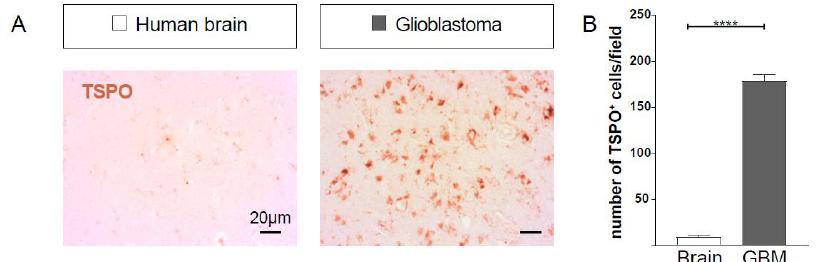
Figure 1. Mitochondrial translocator protein (TSPO) expression is increased in human glioblastoma compared to tumor-free brain tissue. ( A ) Immunohistochemistry of epilepsy ( n = 4) and glioblastoma (GBM) patient samples ( n = 4) was performed. Scale size is indicated in individual micrographs. ( B ) Number of TSPO-positive cells per field of view under a 20 × objective was counted in all immunostained samples. In human GBM, significantly more cells were TSPO-positive compared to a tumor-free brain. Statistical significance ( t -test) is indicated. **** p < 0.0001.